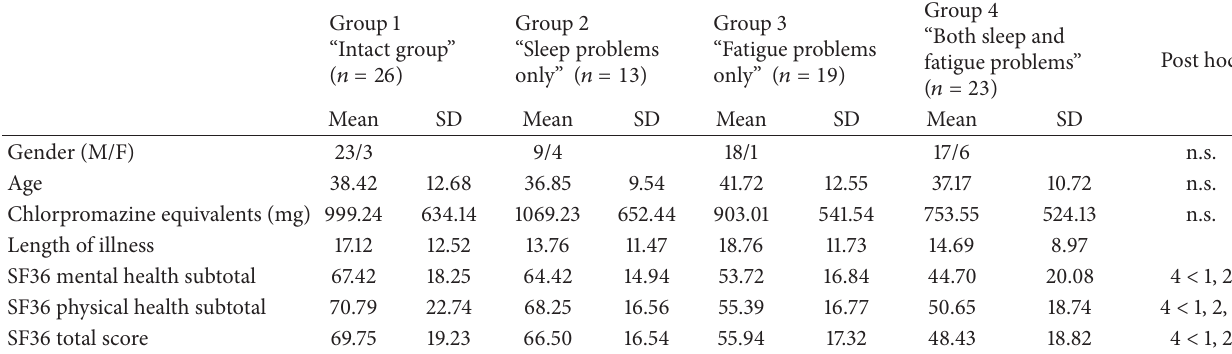
Group 4 “Both sleep and fatigue problems” Post hoc